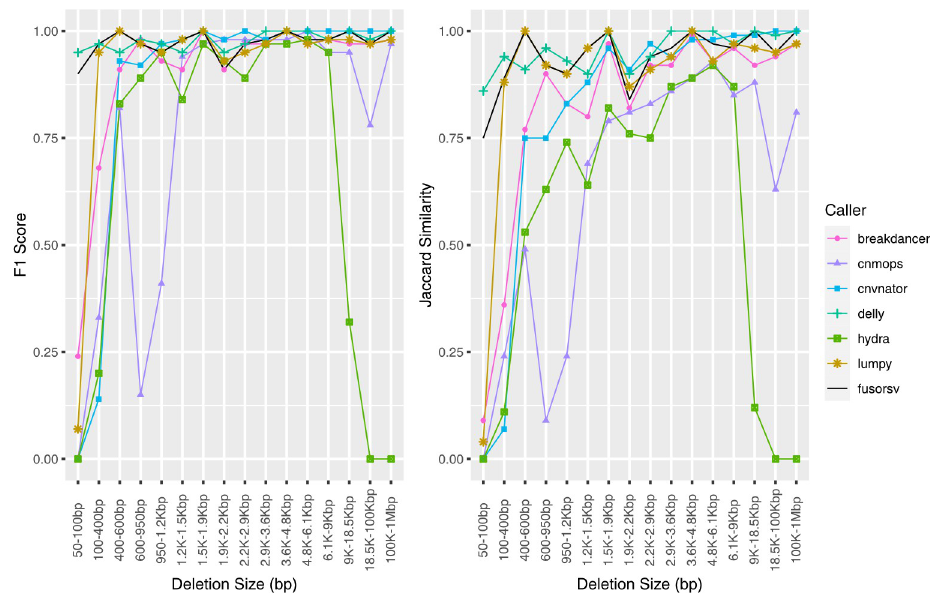
Fig 1. Accuracy of predicted deletions from simulated short-read data. Results shown for 60X depth.